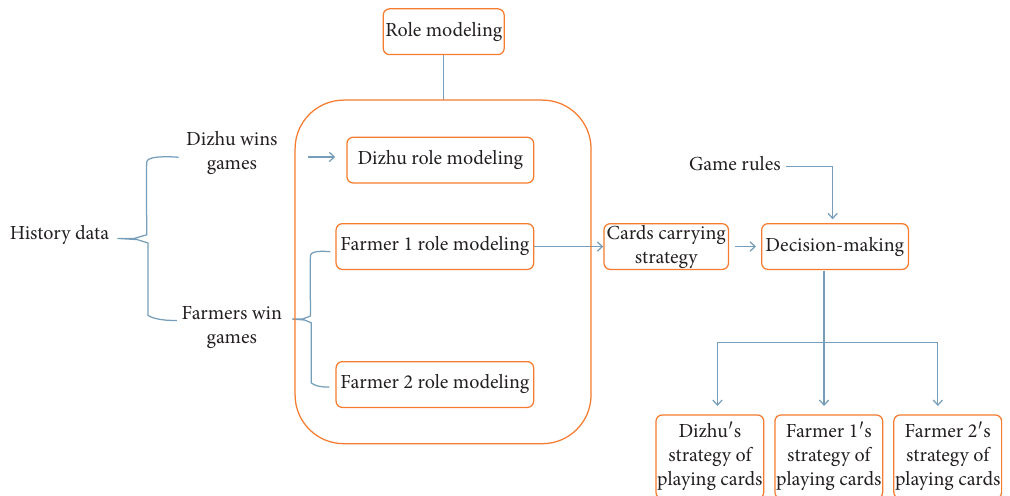
Figure 1: The overall framework of the Doudizhu playing card